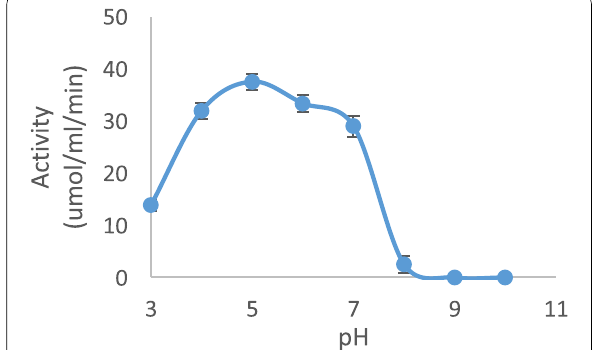
Fig. 2 Effect of pH on amylase obtained from the submerged fermentation of P. mg)